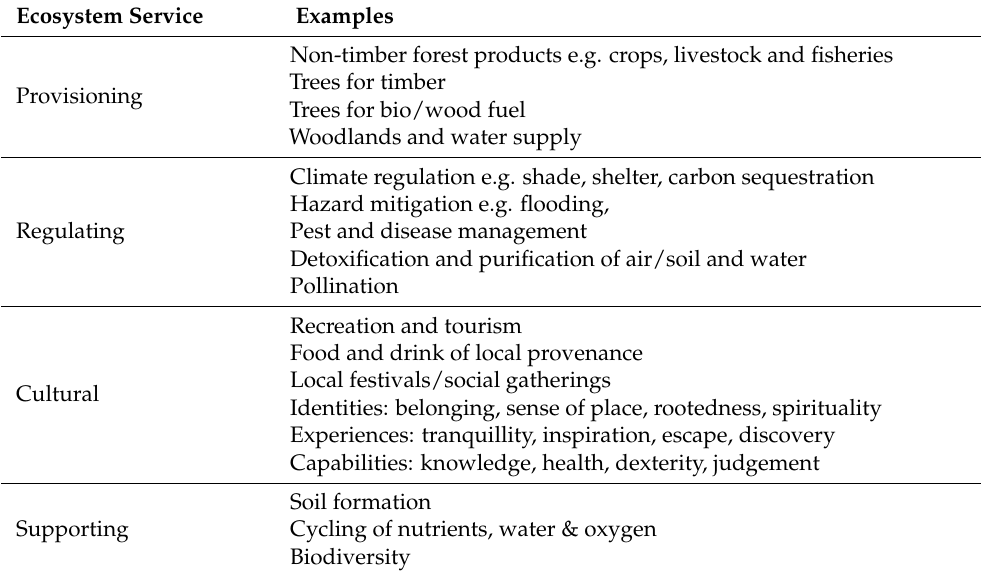
Table 2. Ecosystem Services from Wooded